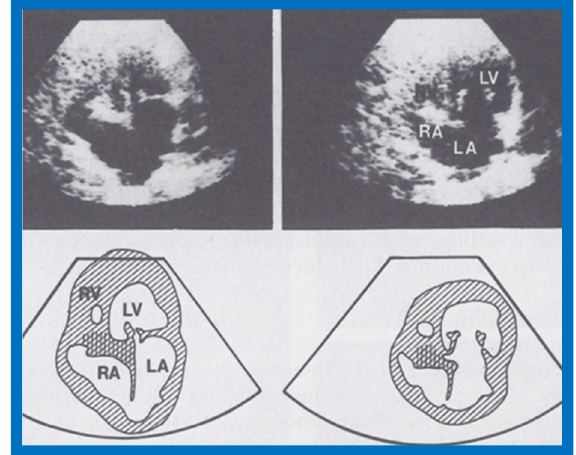
Figure 14. Selected video frames from apical four-chamber view of a two-dimensional (2-D) echocardiographic study demonstrating dense band of echoes between the right atrium (RA) and hypoplastic right ventricle (RV). Line drawings are shown beneath the 2D frames. Note that the mitral valve is closed in the left image while it is open in the right image. The atretic tricuspid valve echoes remain unchanged. LA, left atrium; LV, left ventricle. Reproduced from Covitz W., Rao P.S. [7]. Shortly thereafter, better images (Figures 15 and 16) became available [35,36].